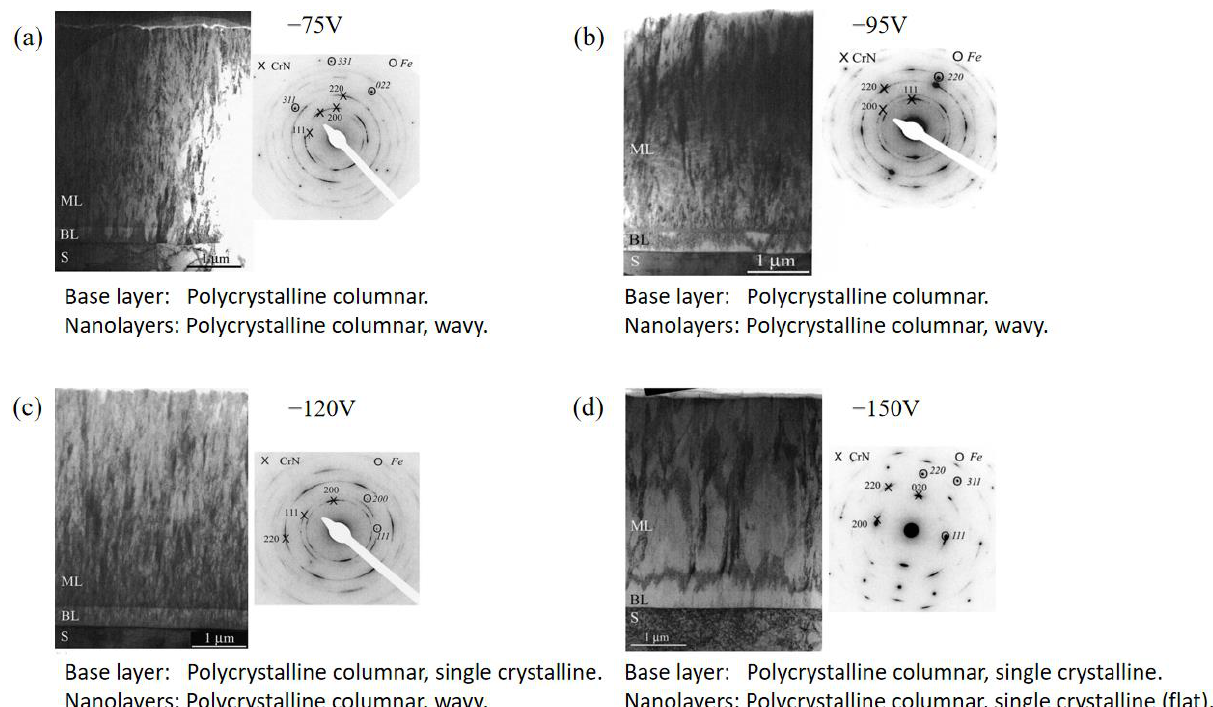
Figure 4. Transmission electron microscope (TEM) micrographs and selected-area electron diffraction (SAED) patterns of CrAlYN/CrN multilayer films deposited at ( a ) U b = −75 V, ( b ) U b = −95 V, ( c ) U b = −120 V, and ( d ) U b = −150 V, showing the change in the microstructure of multilayer films with different deposition biases [20]. Reprinted with permission from [20] American Vacuum Society 2009.